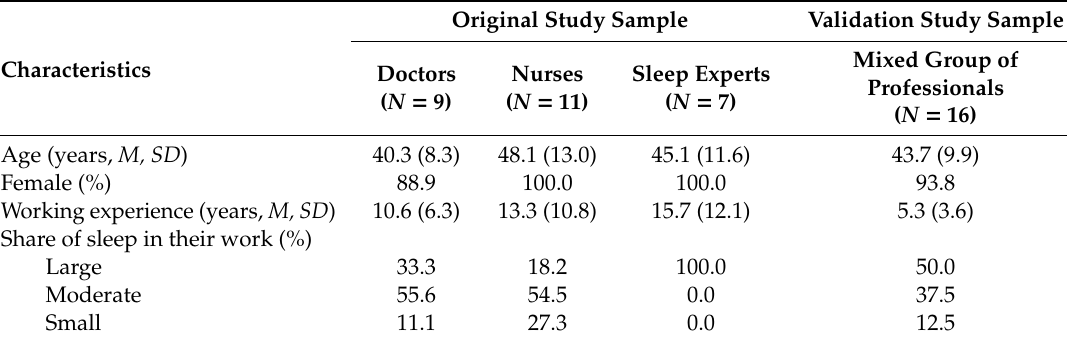
Table 1. Study sample